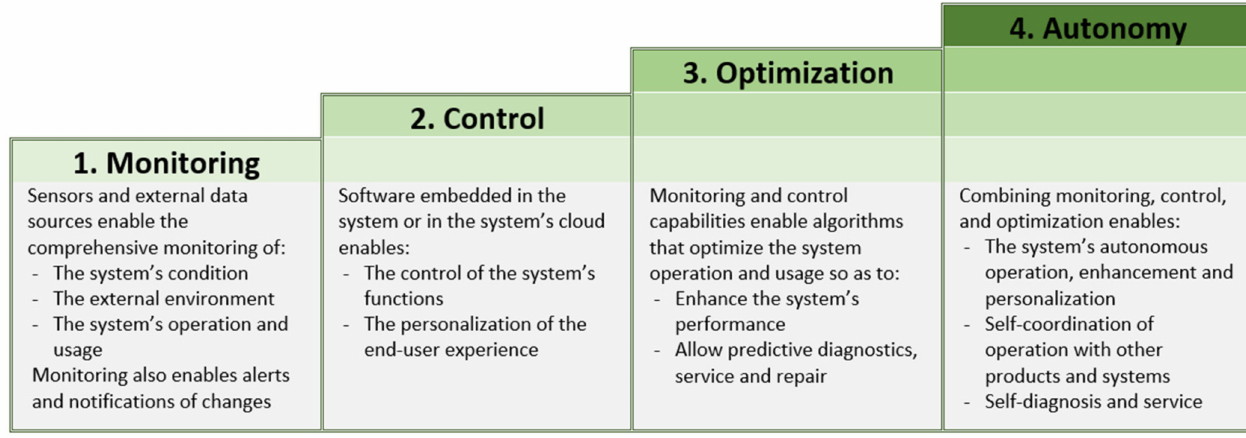
Figure 2. Whole farm approach in integrated farm management (IFM)